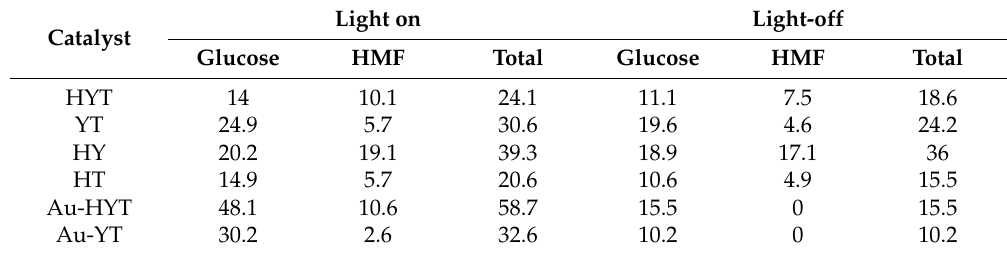
Table 6. Conversion of cellulose using various catalysts, described by Wang et al. [45]. Light on Light-off Catalyst Glucose HMF Total Glucose HMF